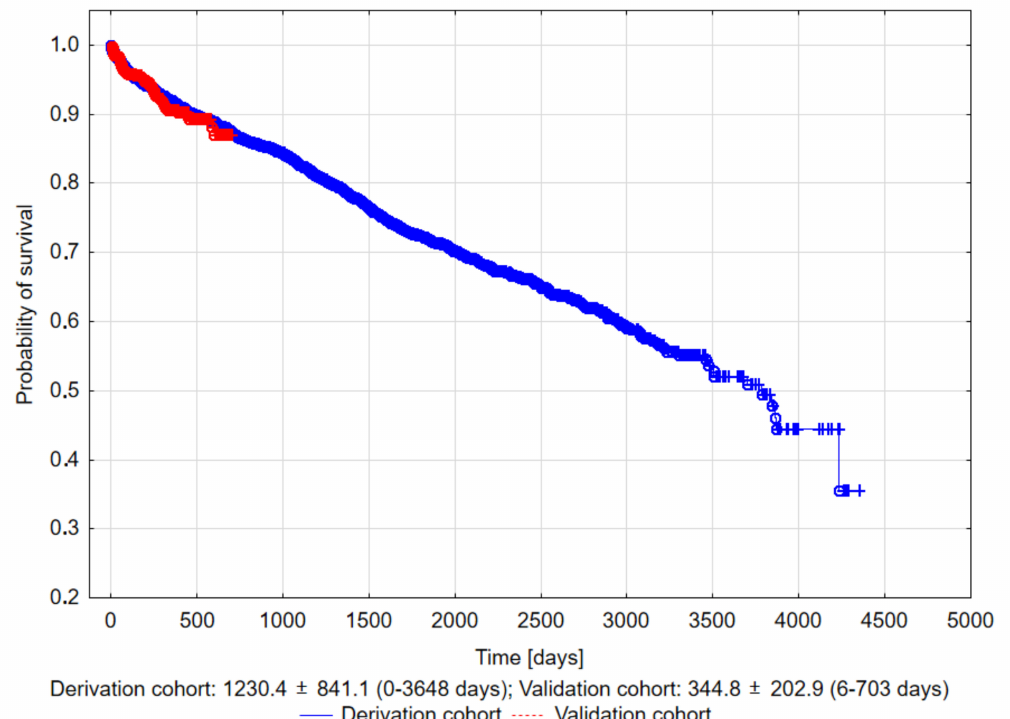
Figure 1. The Kaplan–Meier curve showing the probability of survival after a transvenous lead extraction (TLE) in the derivation and validation cohorts, p =